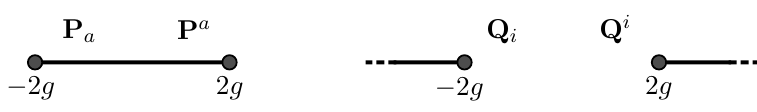
Figure 2 . Analytic structure of the P - and Q -functions on their de(cid:12)ning